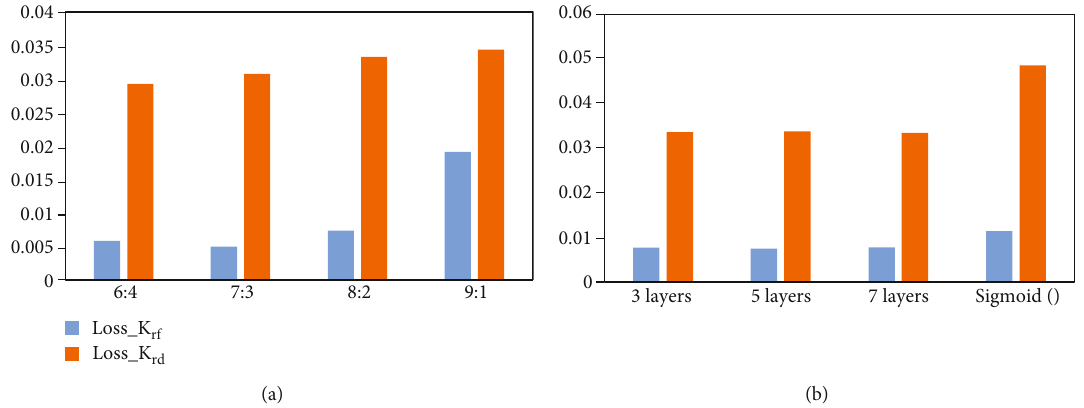
Figure 11: Optimization results of two-phase seepage intelligent model of oil and water. (a) The optimization results of intelligent relative permeability model by adjusting the dividing ratio of the training set and the test set. (b) The optimization results of intelligent relative permeability model by adjusting the number of hidden layers of the deep neural network as well as the activation